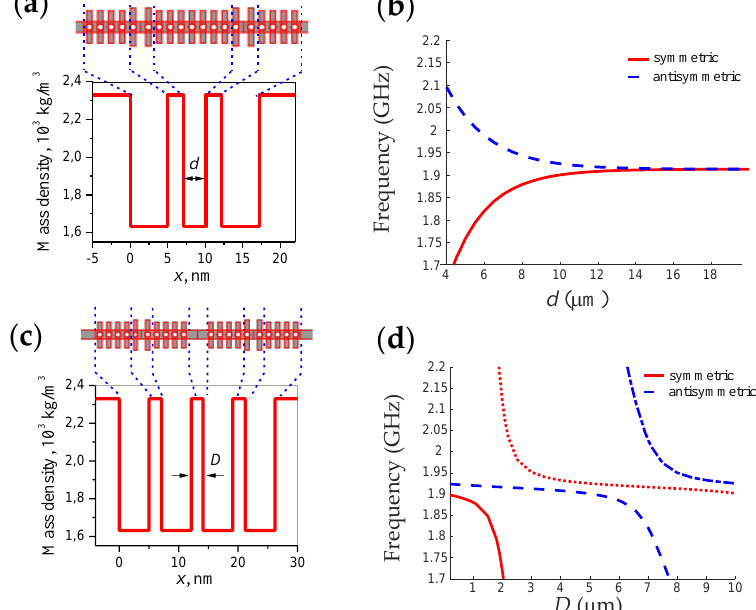
Figure A1. The incoming wave is assumed to be launched from one of sides of the struc- ture under consideration. As can be seen, the mode splitting within the framework of the effective medium model (Figure A1) qualitatively coincides with numerical calculations by the finite element method (Figure 6).